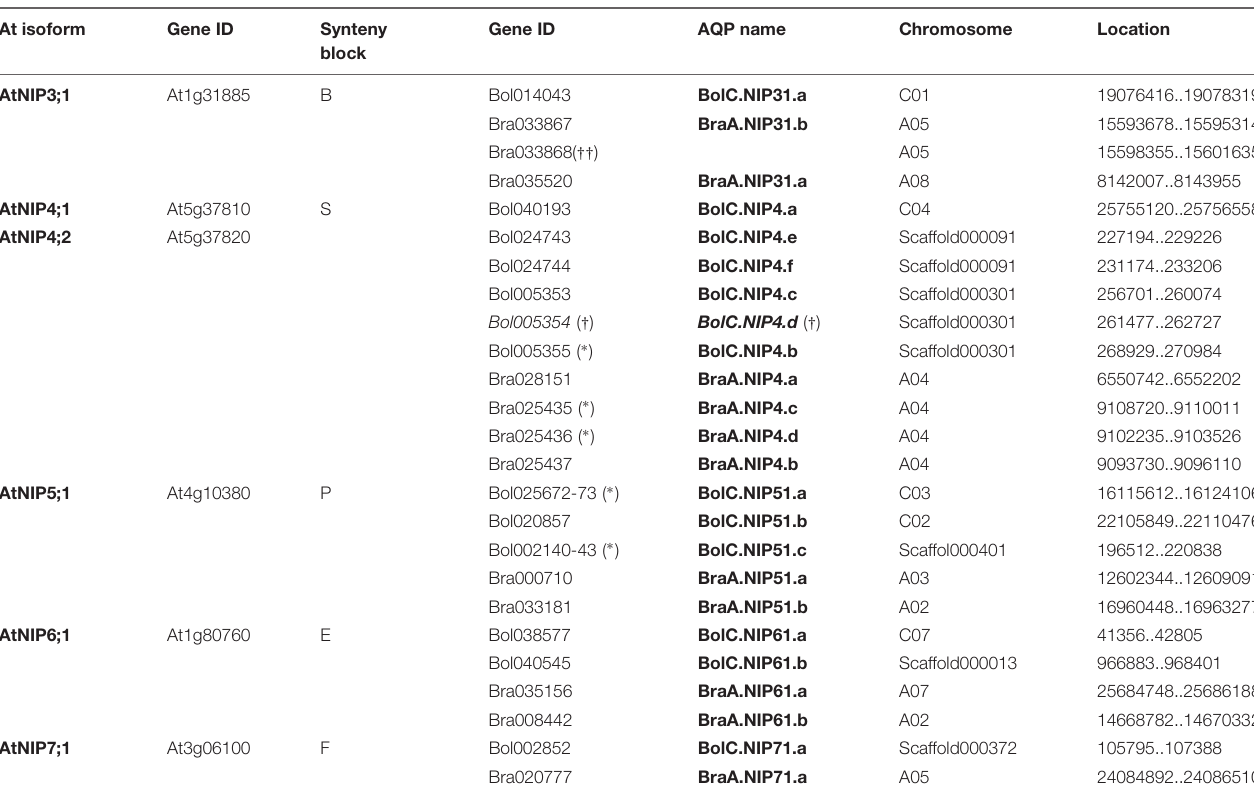
any of the three subgenomes as the surrounding genes on the associated scaffold belonged to different karyotype blocks.